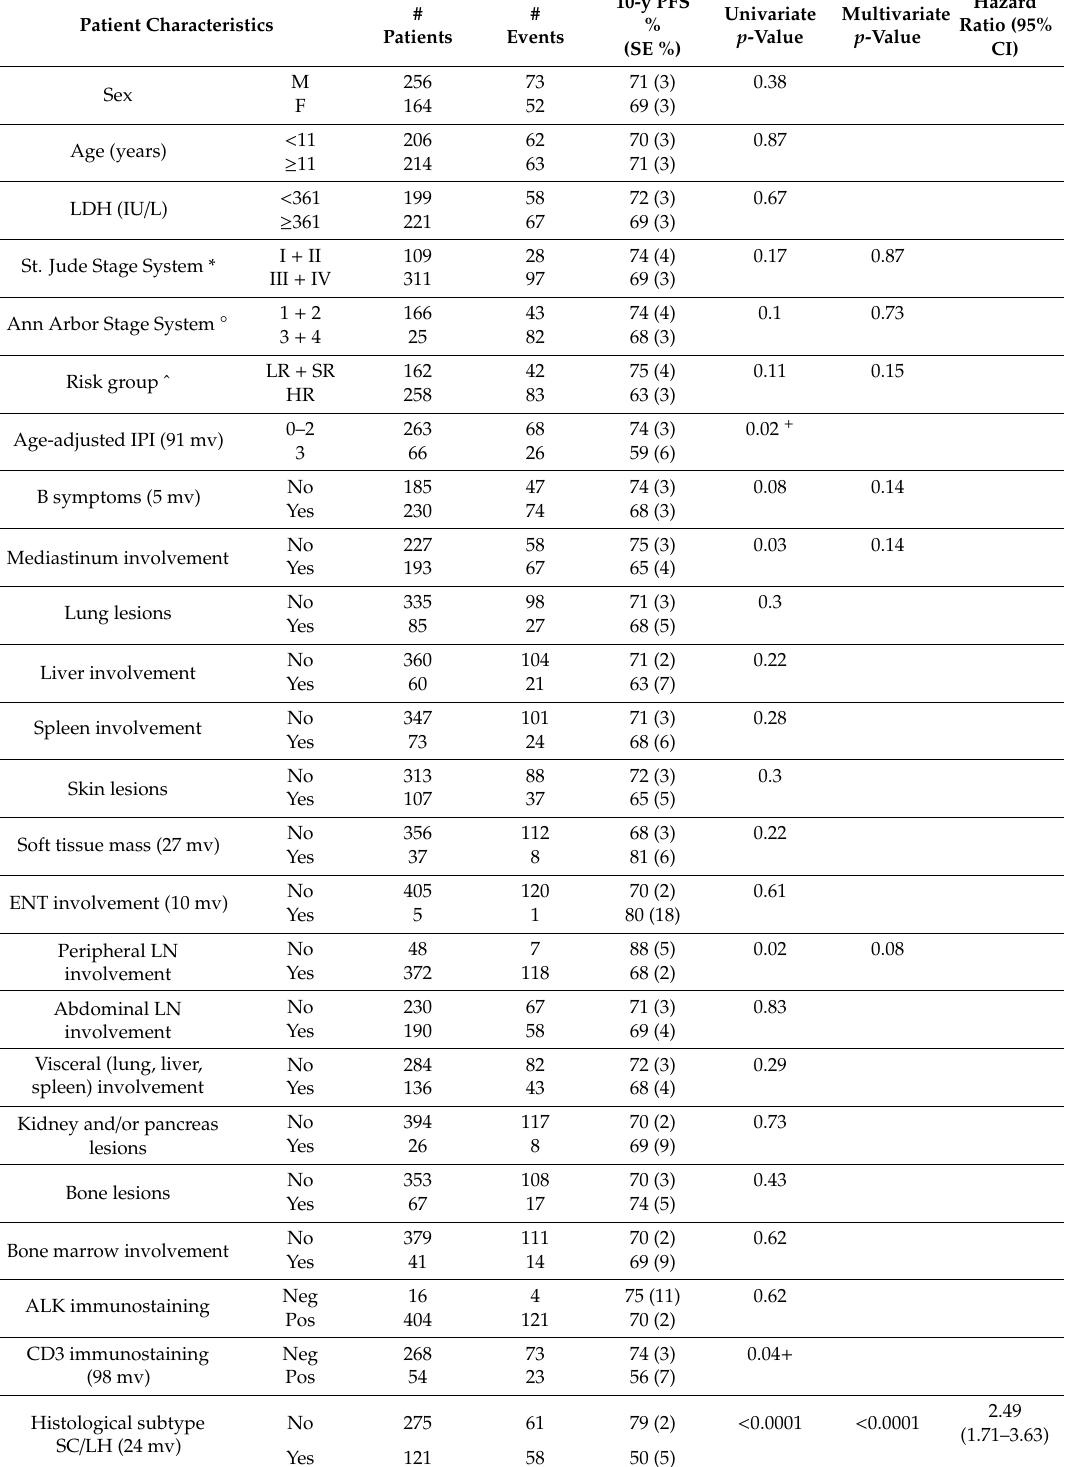
Table 1. Patient and disease characteristics of the whole study cohort (420